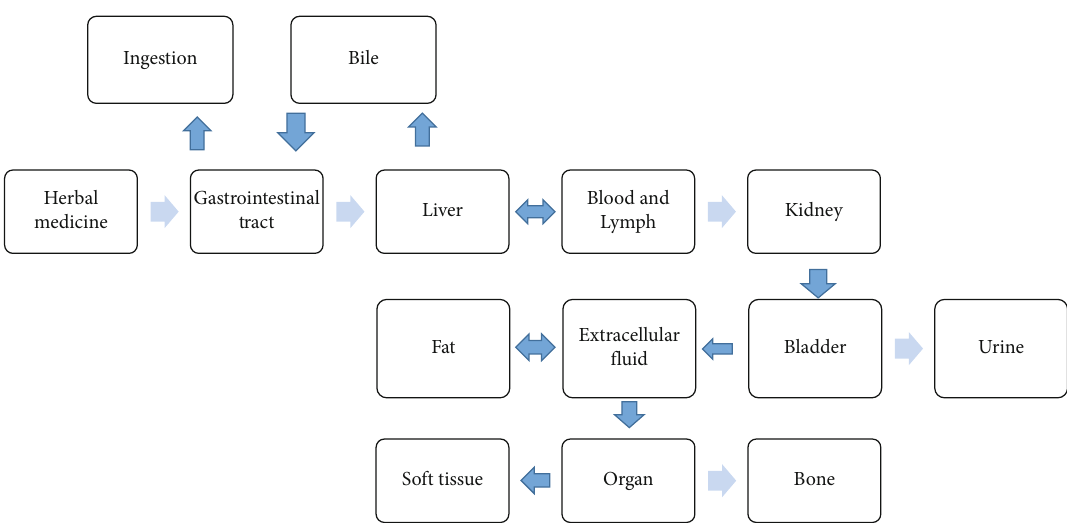
Figure 2: Interaction and fate of toxic metal in human body through ingestion of herbal medicine (Encyclopedia Britannica, 1994).